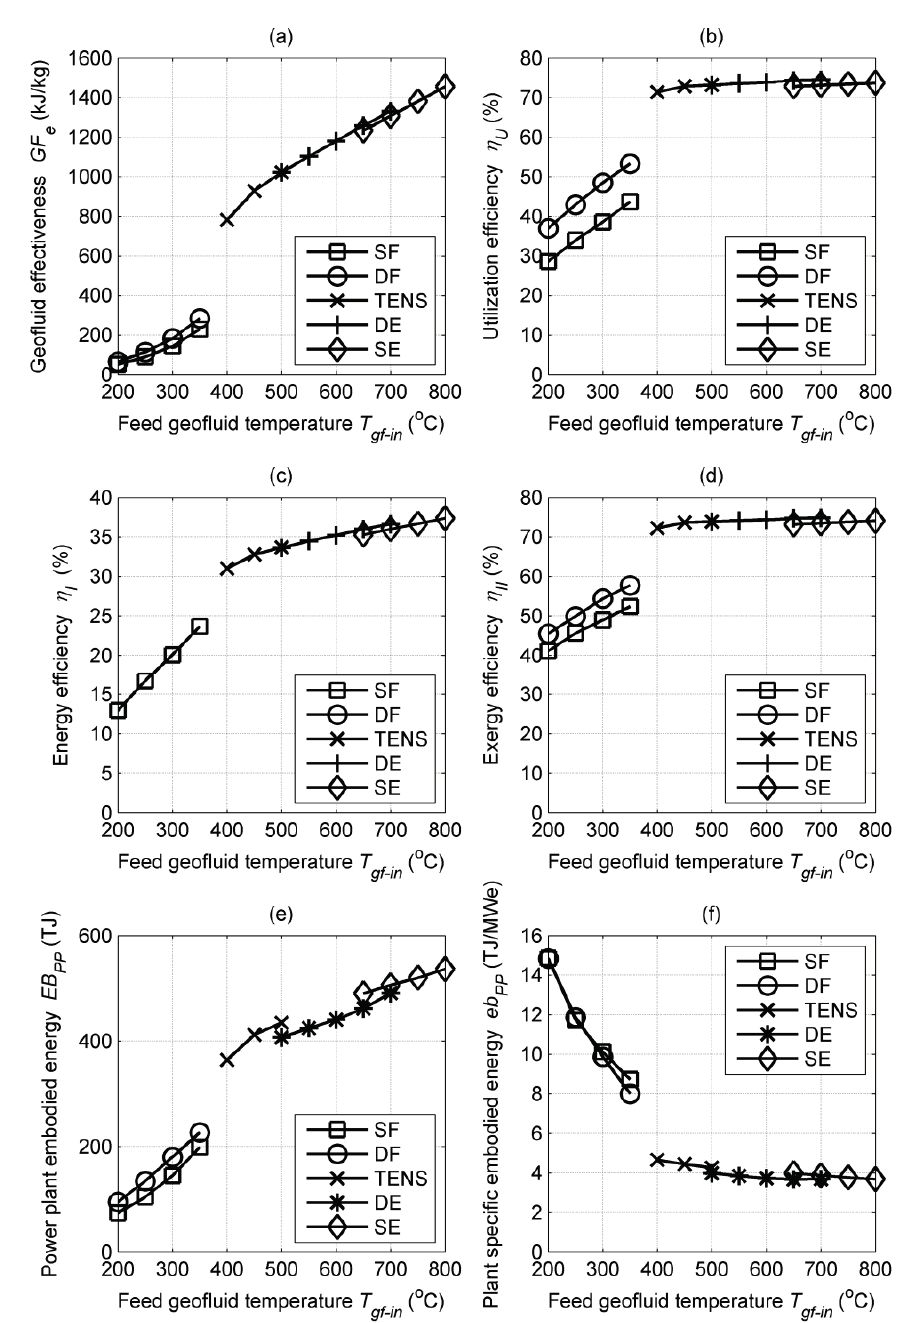
Figure 2. Geofluid effectiveness ( a ) and power plant utilization efficiency ( b ), plant energy efficiency ( c ) and exergy efficiency ( d ), power plant embodied energy ( e ) and power plant specific embodied energy ( f ) with respect to T gf_in for different plant configurations with air-cooled condensers. SF: single flash; DF: double flash; TENS: triple expansion without superheating; DE: double expansion; SE: single expansion. The result for TES is in Table